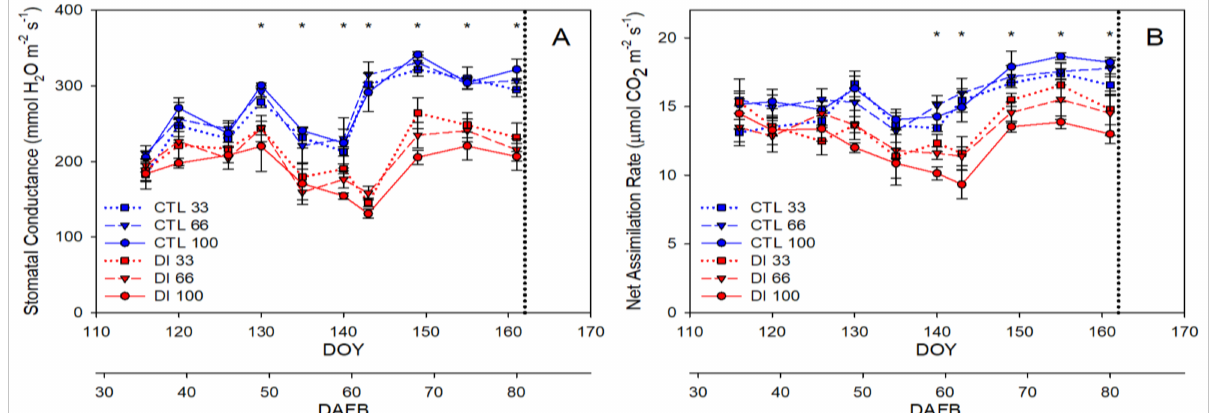
Figure 2. Seasonal evolution of stomatal conductance ( A ) and net assimilation rate ( B ) for the two irrigation treatments: CTL (full irrigated treatment; blue) and DI (deficit irrigation treatment; red), and the three levels of crop load: low (33%, squares), medium (66%, triangle), and high (100%, circle). Each point is the mean ± SD of three trees. Asterisks indicate significant differences between CTL and DI, according to ANOVA ( p < 0.05). The vertical dotted line indicates the harvest day (day of year, DOY 162; days after full bloom, 81 DAFB). Full bloom: 22 March 2019; harvest day: 11 June 2019.